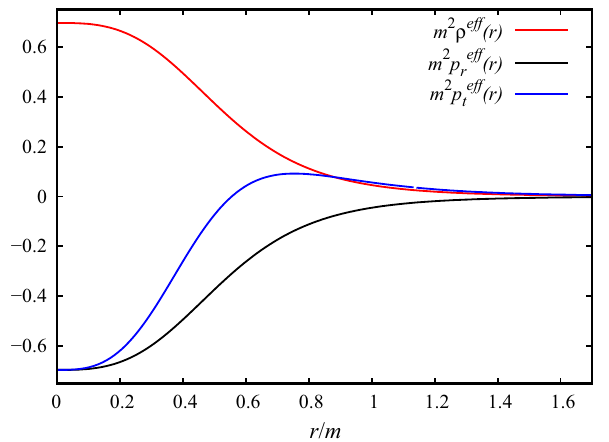
Fig. 11 Effective energy density and effective pressures for the Hay- √ ward solution for κ = 8 π and q = 0 . 7